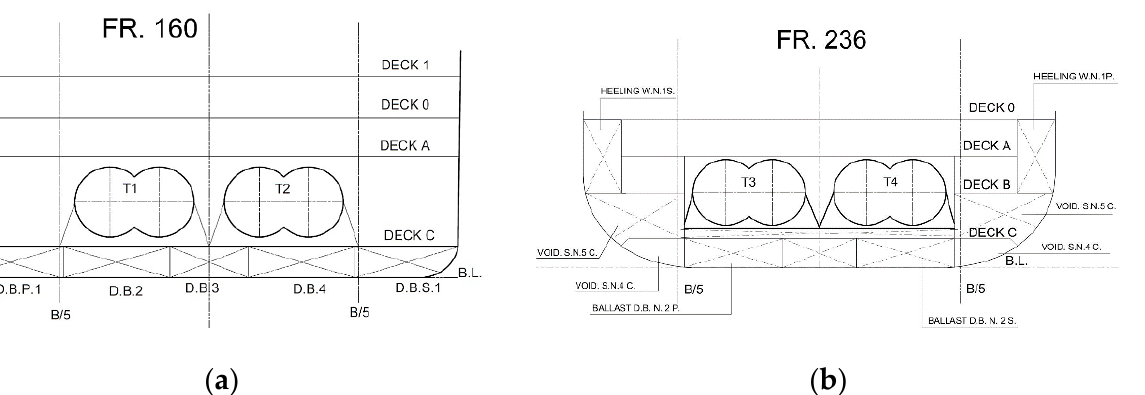
J. Mar. Sci. Eng. 2023 , 11 , 67 Figure 5. Type-C bilobed tanks ’ location: ( a ) Section at frame 160; ( b ) Section at frame 236. Figure 5. Type-C bilobed tanks’ location: ( a ) Section at frame 160; ( b ) Section at frame 236.